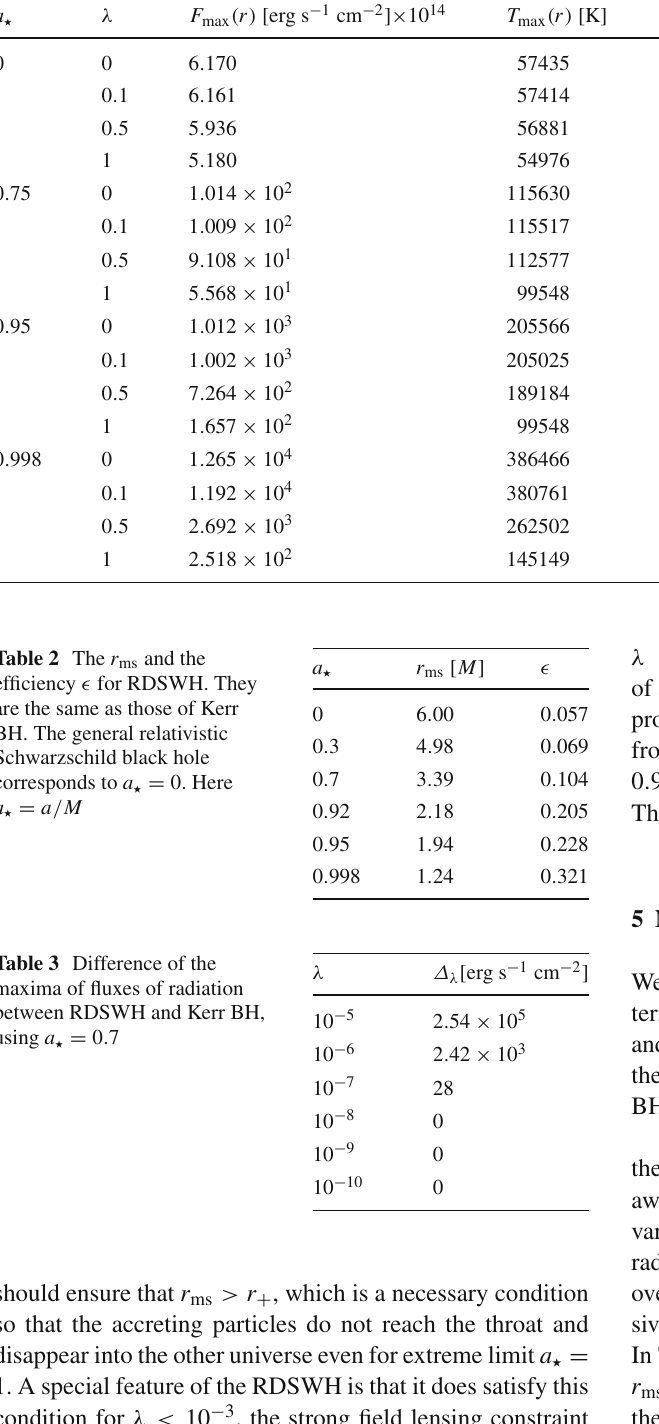
The critical values of radius r crit and of frequency ν crit where the corre- sponding maxima occur is shown in the columns 5 and 7 respectively